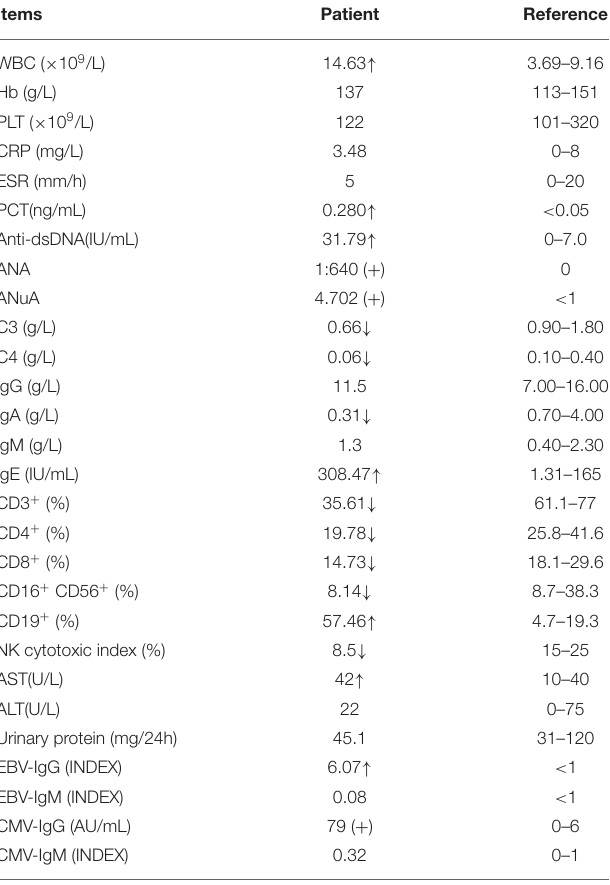
TABLE 1 | Immune indices of